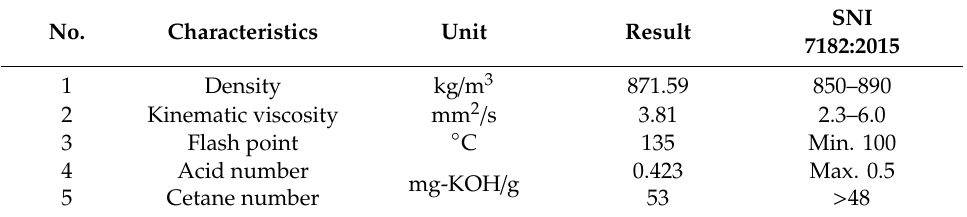
Table 4. Characteristics of obtained biodiesel compared to Indonesian quality standard (SNI).